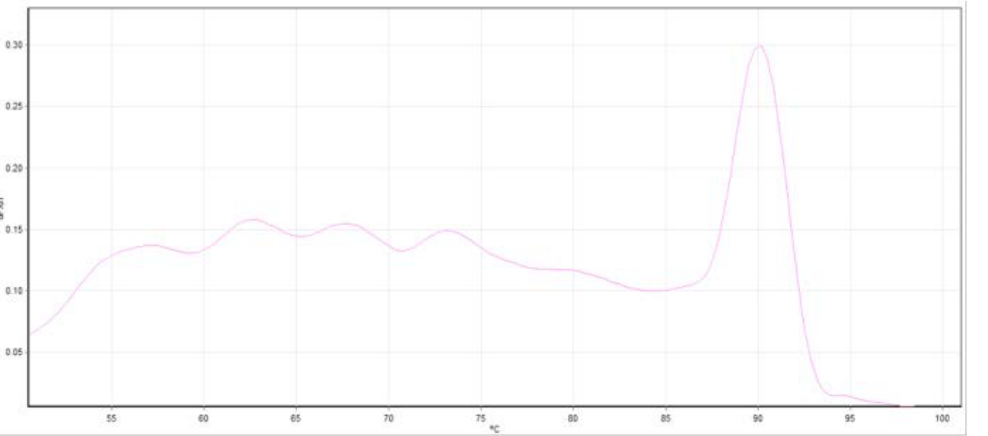
Fig. 2. Positive sample for mcr1 gene by SYBR Green real-time PCR.